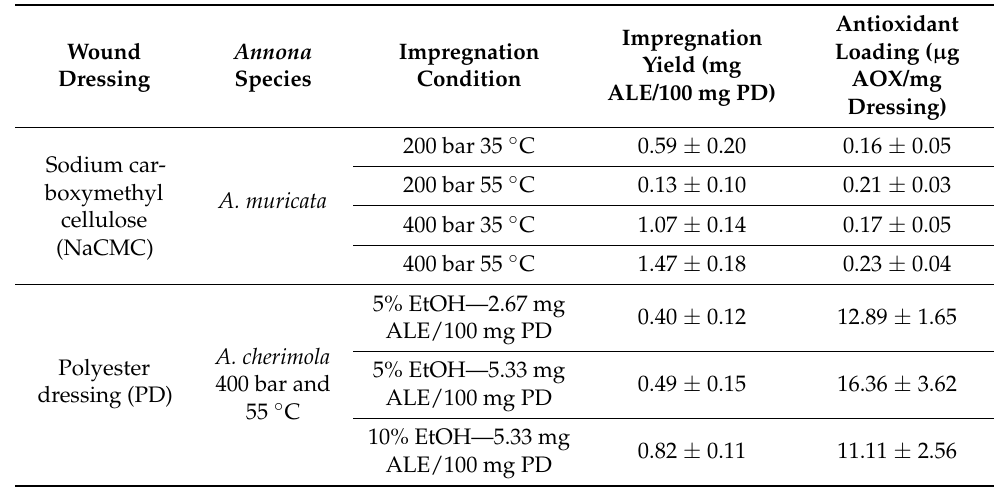
Table 4. Impregnation yield and antioxidant loading of dressings under different conditions for A. muricata leaf extract into NaCMC and A. cherimola cv. Alboran leaf extract into